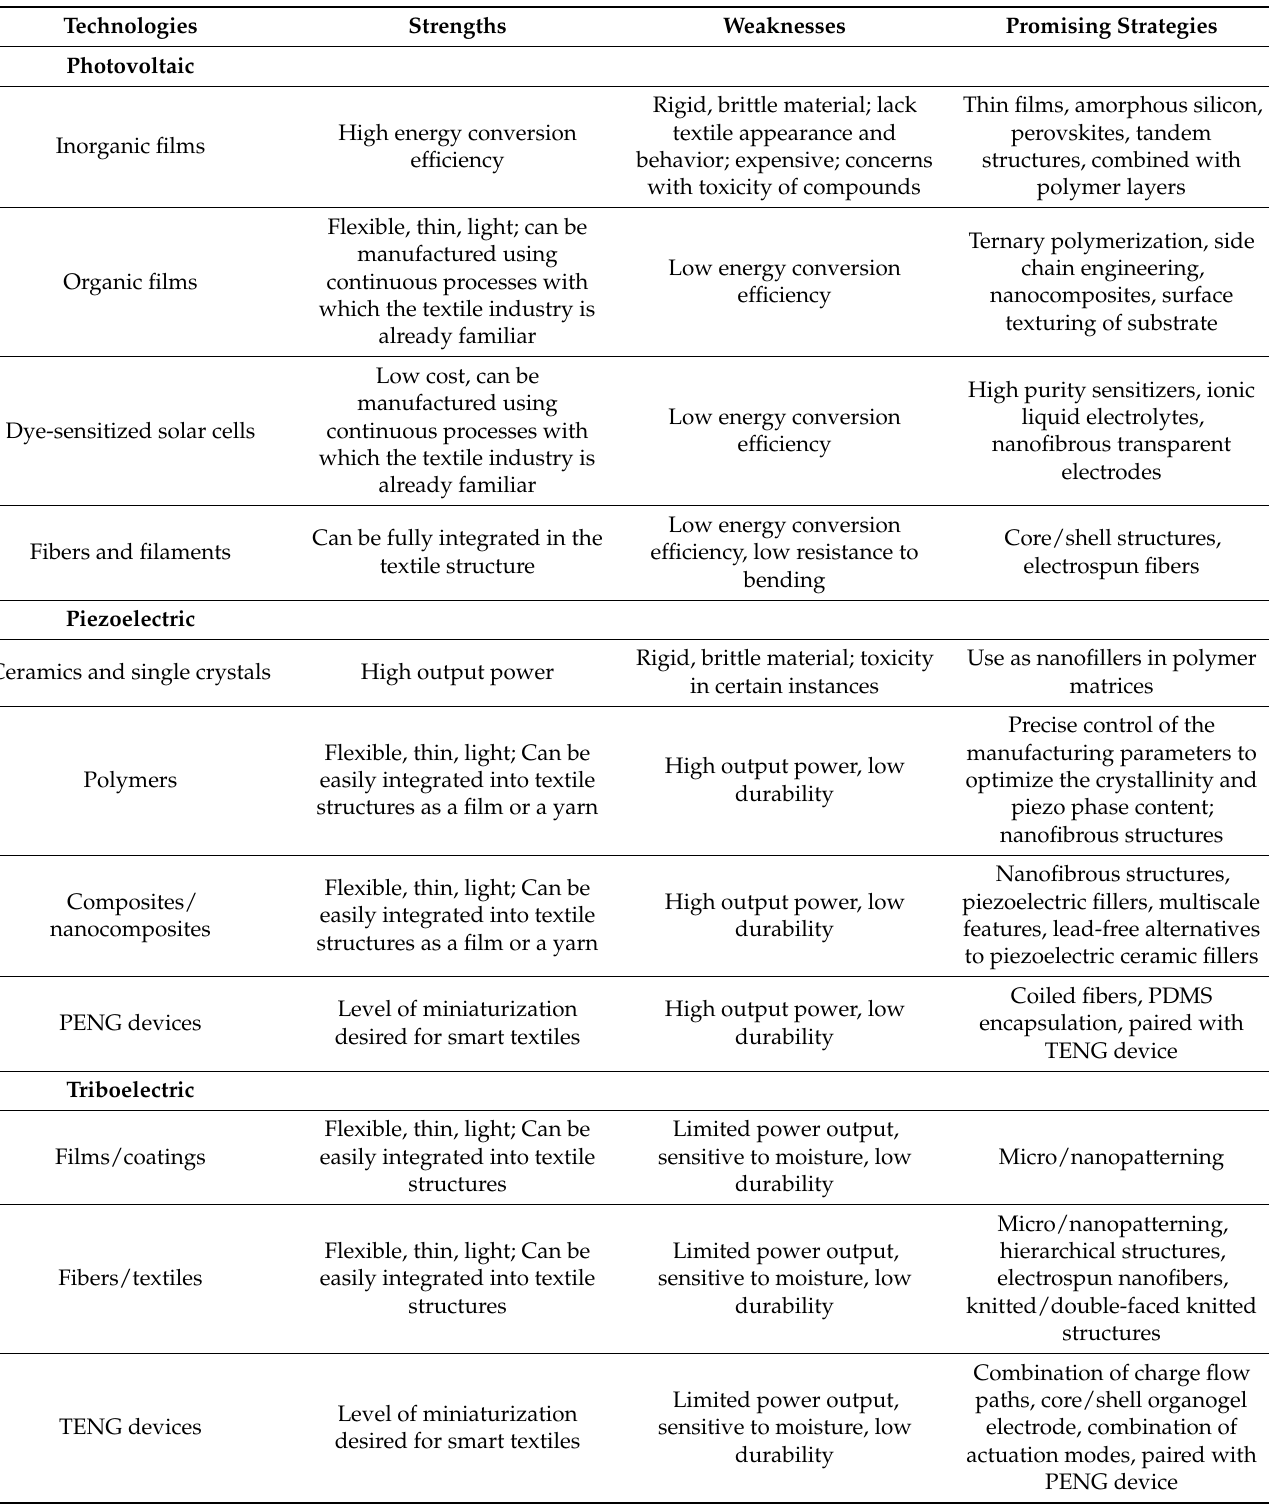
Table 1. Strengths and weaknesses of photovoltaic, piezoelectric, triboelectric, and thermoelectric energy harvesting in the context of smart/e-textiles applications, and promising